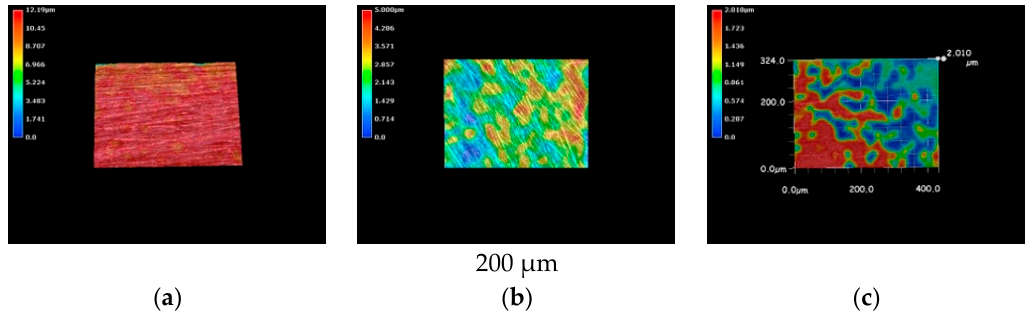
Figure 3. The 3D images by the optical microscopy for pure nickel specimens. ( a ) Before immersion; ( b ) resident microbiota; ( c ) E-coli .